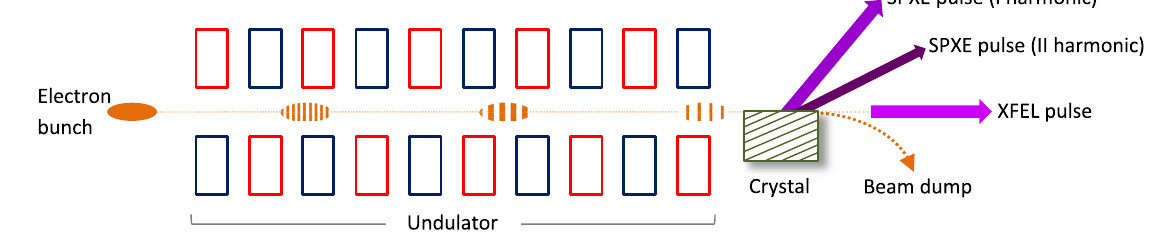
FIG. 1. Qualitative scheme of the processes which lead to the generation of SPXE pulses in the XFEL